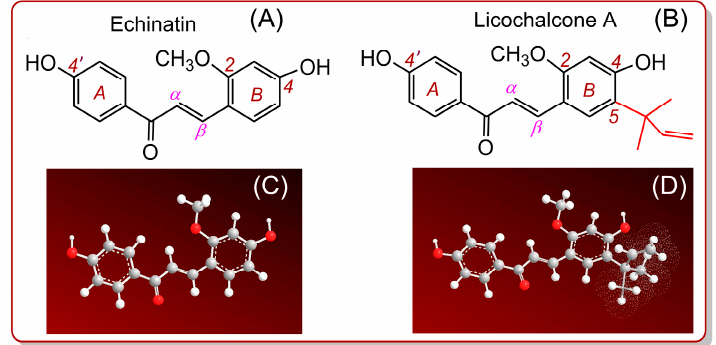
Figure 1. Structural formulas and molecular models of echinatin and licochalcone A: A , structural formula of echinatin; B , structural formula of licochalcone A; C , preferential conformation-based molecular model of echinatin; and D , preferential conformation-based molecular model of licochalcone A. The molecular models were created based on molecular mechanics calculations using Chem3D Pro 14.0. (red, O; gray, C; white, H).